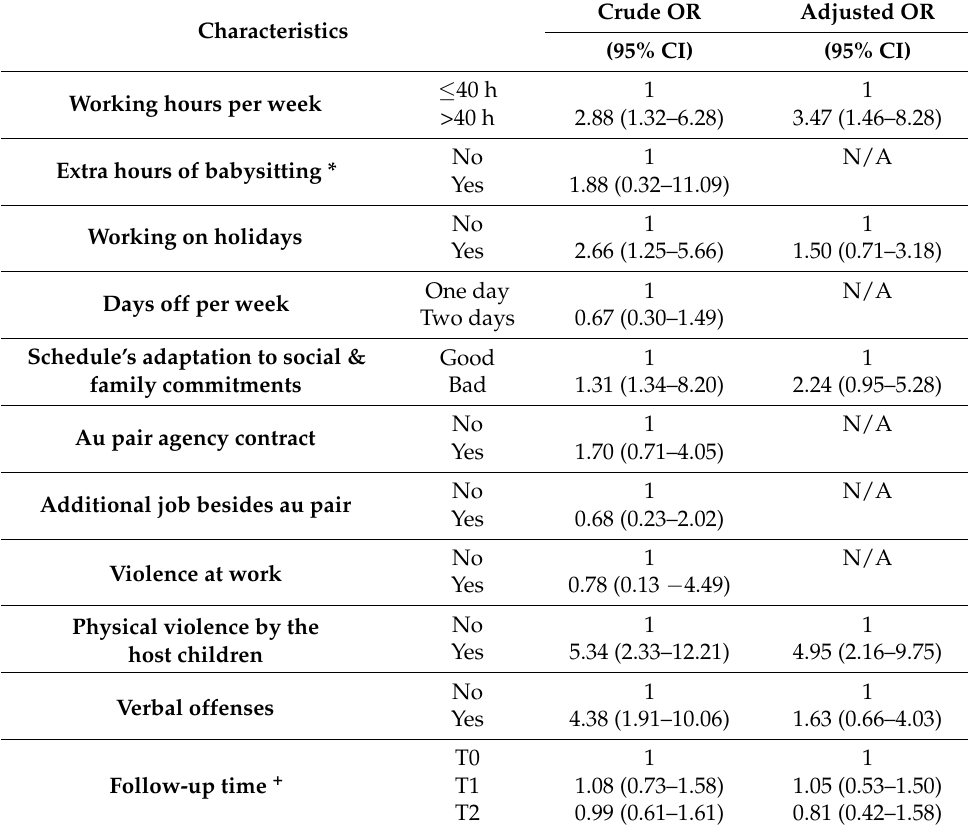
Table 4. Generalized estimating equations (GEEs) for depressive symptoms ( N =